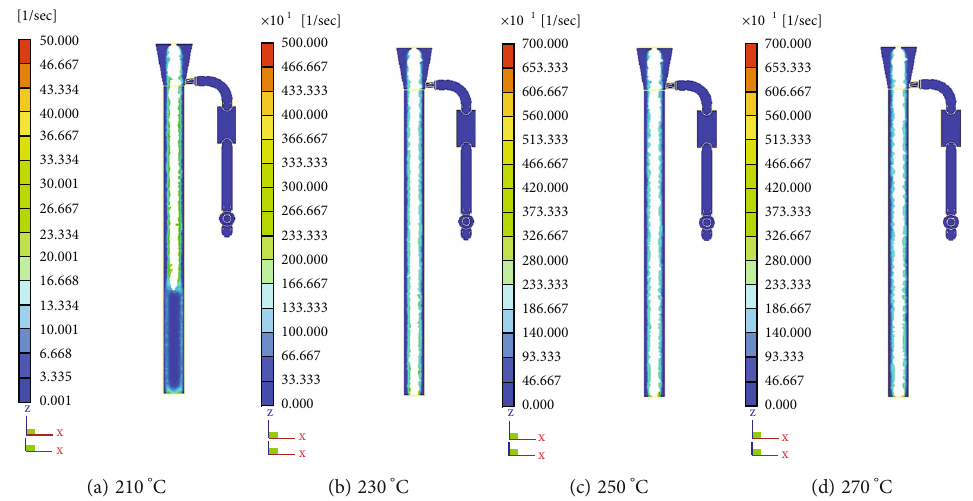
Figure 11: Shear rate distribution at di ff erent melt